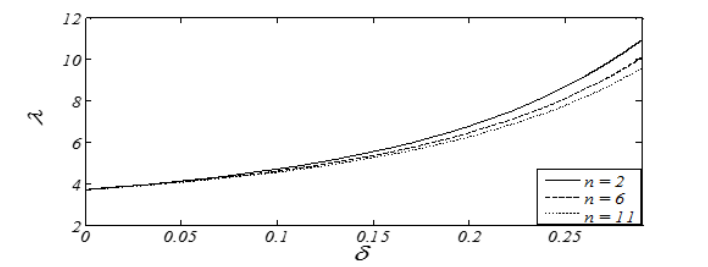
Fig. 11 Resistance impedance for F=0.6, L=1, a=0.2, b=0.4, m=2.